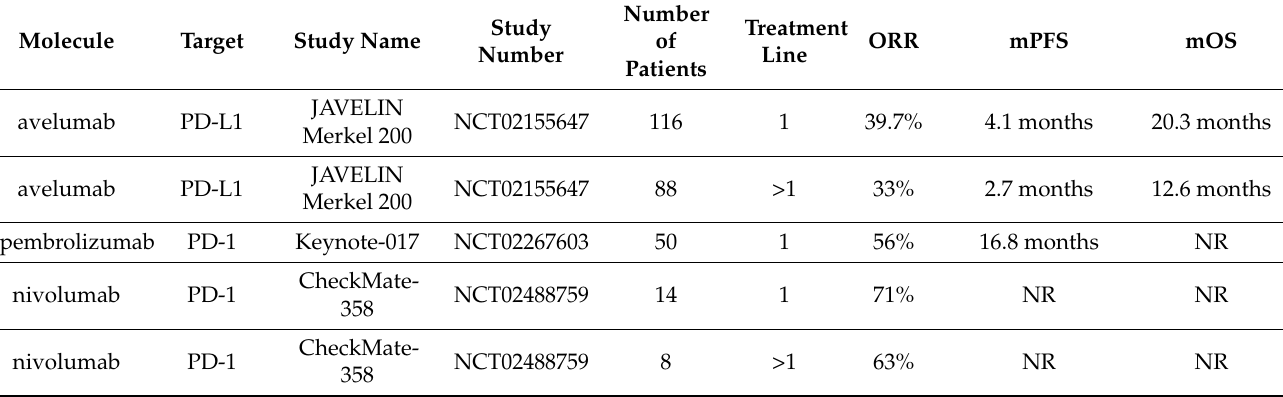
Table 2. The summary of anti-PD-L1/anti-PD-1 antibodies efficacy in advanced/metastatic MCC.